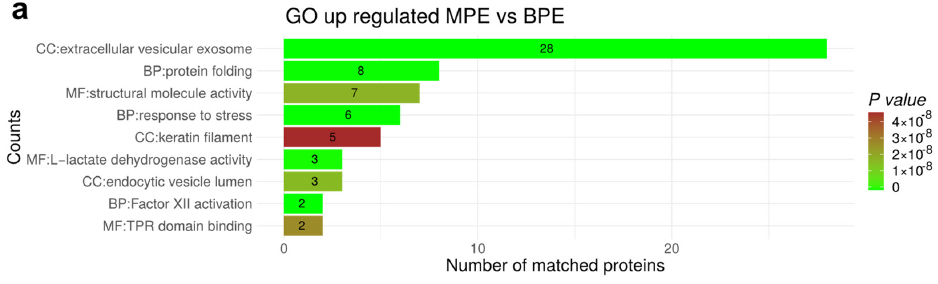
Figure A2. Functional analysis for significant up-regulated proteins by comparing MPE versus BPE proteome. ( a ) Shows the significant GO analysis of up-regulated proteins ( p -value < 0.05) between MPE and BPE (CC, Cellular component; BP, biological process; MF, molecular function), ( b ) KEGG pathway enrichment analysis for up-regulated proteins by comparing MPE and BPE.